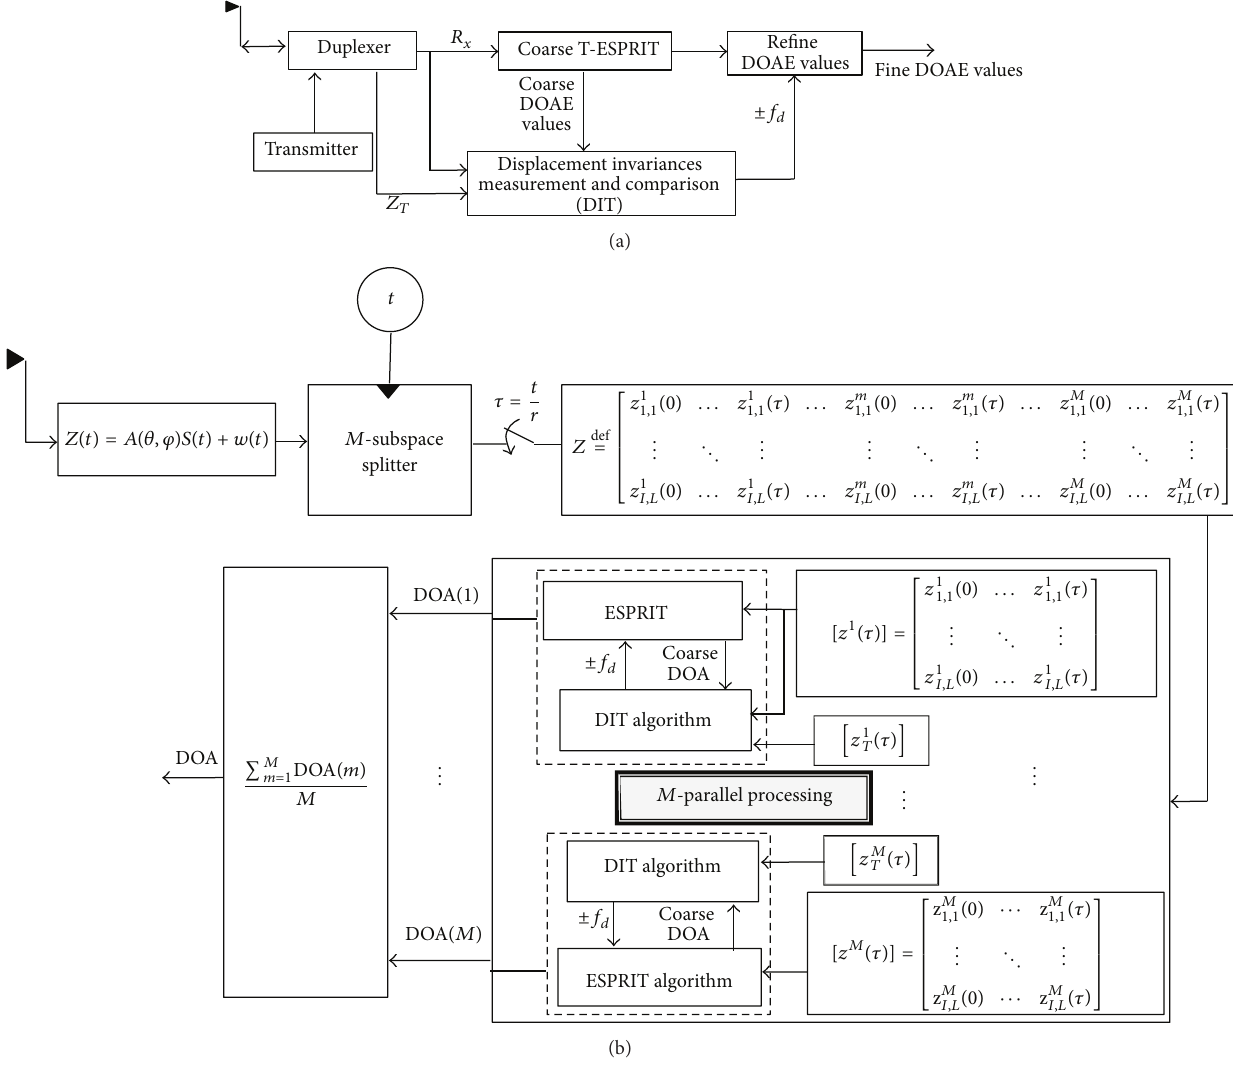
Figure 4: T-DIT and Doppler correction for T-ESPRIT algorithm (a) general scheme and (b) detailed scheme. Table 3: Comparison of the required computation time and